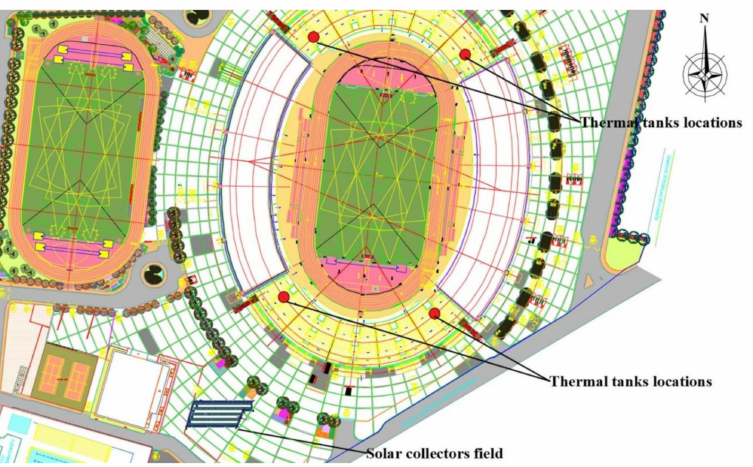
Figure 11. The locations of the solar collectors’ installation field and the four thermal storage